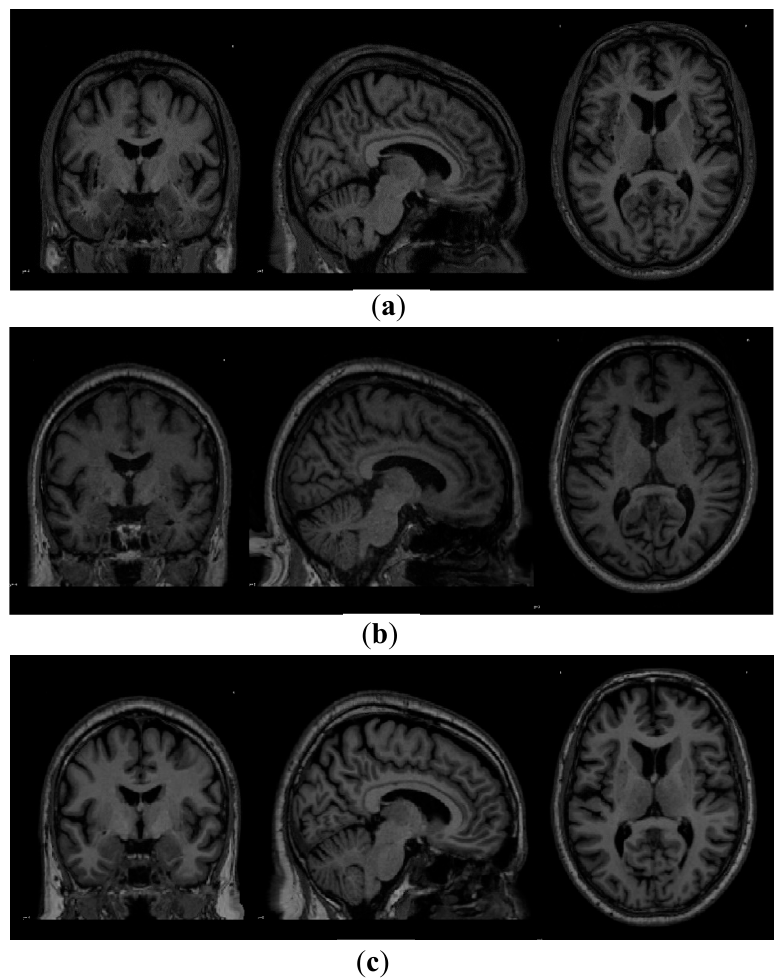
Table 3. Specification of the acquired scans from PPMI.